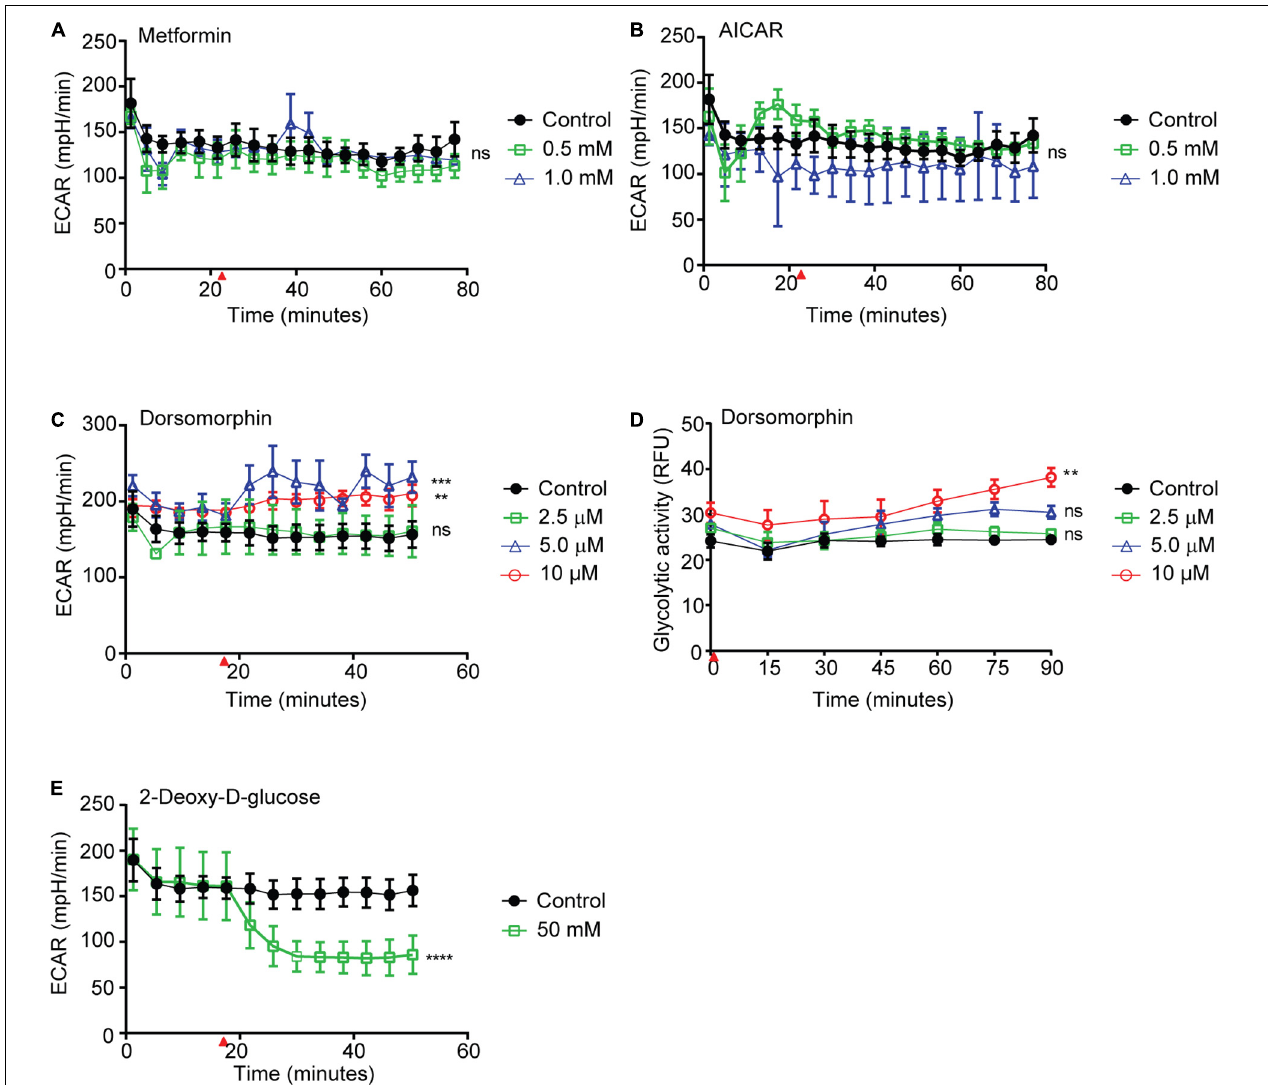
FIGURE 1 | Effects of AMPK agonists and inhibitor on S. mansoni glycolytic activity. (A–C) The extracellular acidification rate (ECAR) of freshly isolated adult S. mansoni pairs exposed to metformin (A) , AICAR (B) , and dorsomorphin (C) , were measured using Agilent Seahorse XFe96 system. (D) Extracellular acidification, measured in relative fluorescence units (RFU), of freshly isolated adult schistosome pairs after exposure to dorsomorphin, measured using Agilent pH-Xtra Glycolysis Assay. (E) ECAR of freshly isolated adult S. mansoni pairs exposed to 2-Deoxy- D -glucose. Red arrows in (A–C) , (E) indicate time point at which each test compound was introduced into parasite culture media. Individual data points shown are the average of at least 3 biological replicates. Each graph is representative of at least 2–3 independent experiments. ns P > 0.05, ** P ≤ 0.01, *** P ≤ 0.001, **** P ≤ 0.0001.